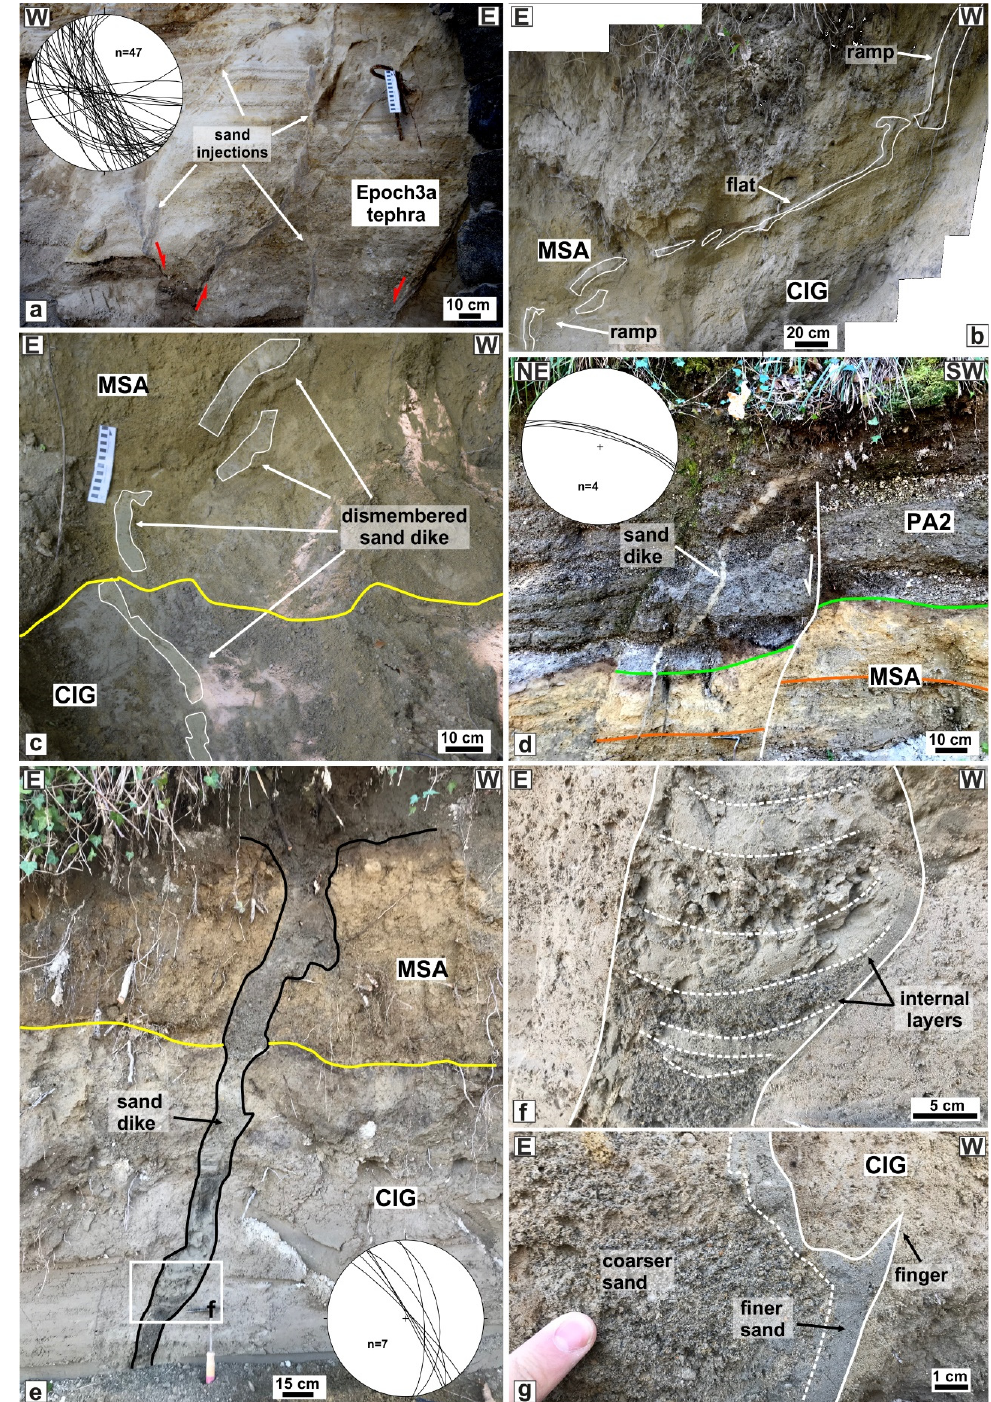
Figure 5. La Pietra (site 4): ( a ) sand injections associated with several faults within Agnano 1-2 tephra and stereographic projection of fault planes. Gauro volcano (site 5): ( b ) panoramic view of a ramp-flat sand dike within Cigliano (CIG) tephra; ( c ) particular of the dismembered dike; ( d ) Neptunian dike and normal faults within Paleoastroni2 (PA2) and Monte Sant’Angelo (MSA) tephra, and stereographic projection of dike boundaries; ( e ) sand dike with dewatering structures within MSA and Cigliano tephra, and stereographic projection of dike boundaries; ( f ) particular of the dike showing the downward convex lamination; ( g ) particular of the dike showing the coarser core and finer rim with a small